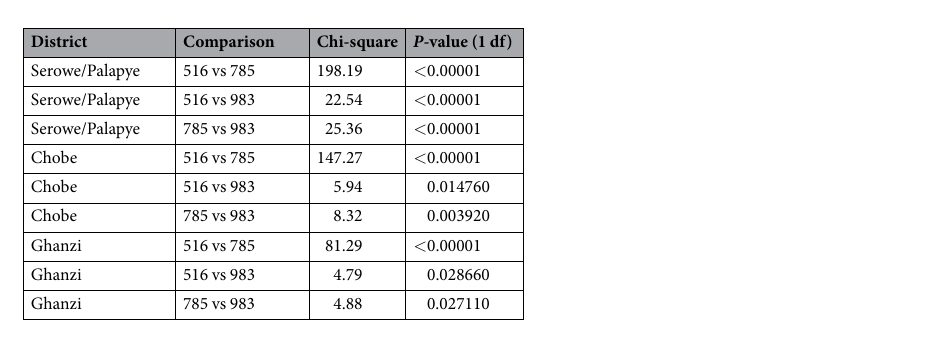
Table 2. Pairwise LD analysis for the three polymorphic loci. Chi-square values and P -value for LD analysis were obtained using Arlequin. Significance is assumed for P < 0.05.